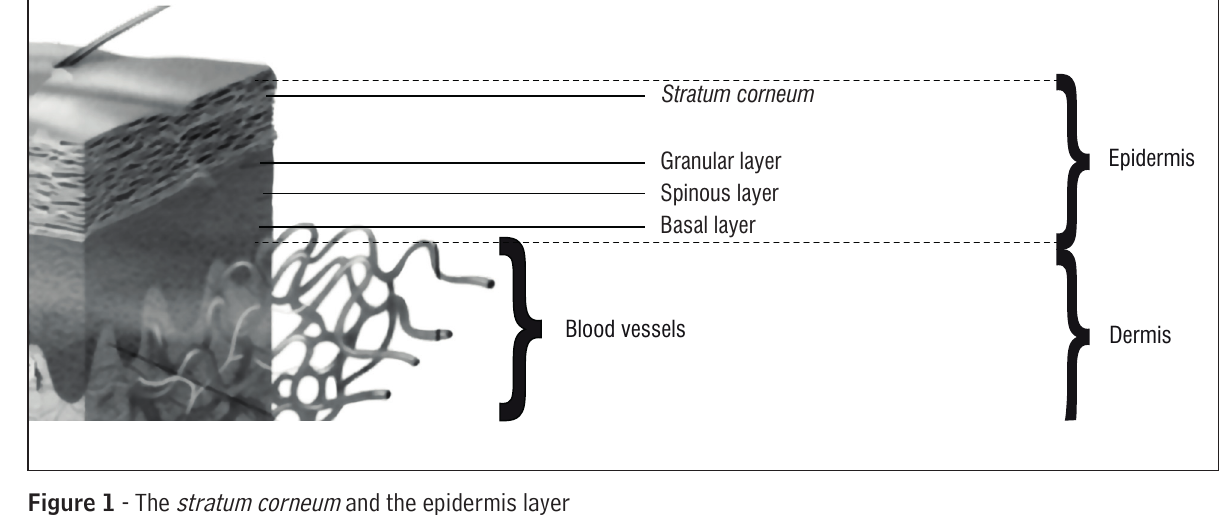
Figure 1 - The stratum corneum and the epidermis layer Source: Modi fi ed from Saúde Total (28).